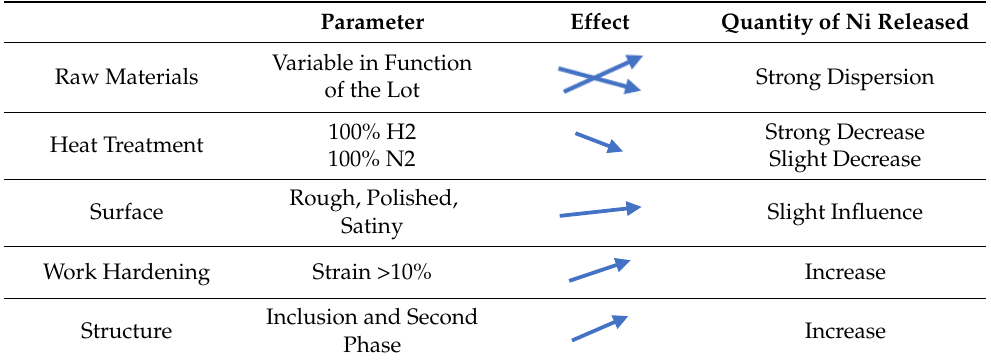
Table 2. Factors influencing the amounts of nickel released during the manufacturing process.